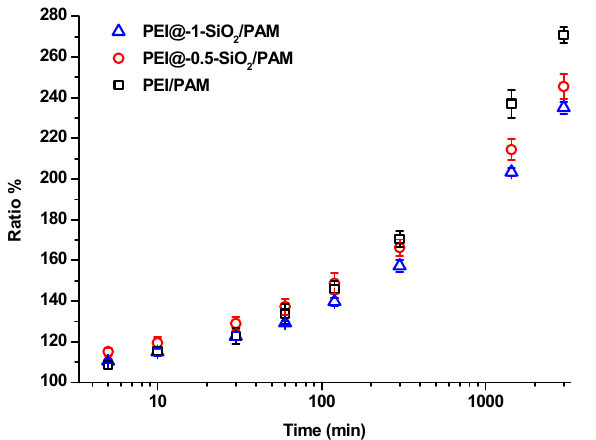
Figure 9. Swelling ratio of HPs-modified hydrogel samples (PEI/PAM, PEI@-0.5-SiO 2 /PAM, and PEI@-1-SiO 2 /PAM) as a function of immersing time, m SiO2 :m PEI = 0:1, 0.5:1 and 1:1, respectively. The swelling tests for each composition were repeated three times.